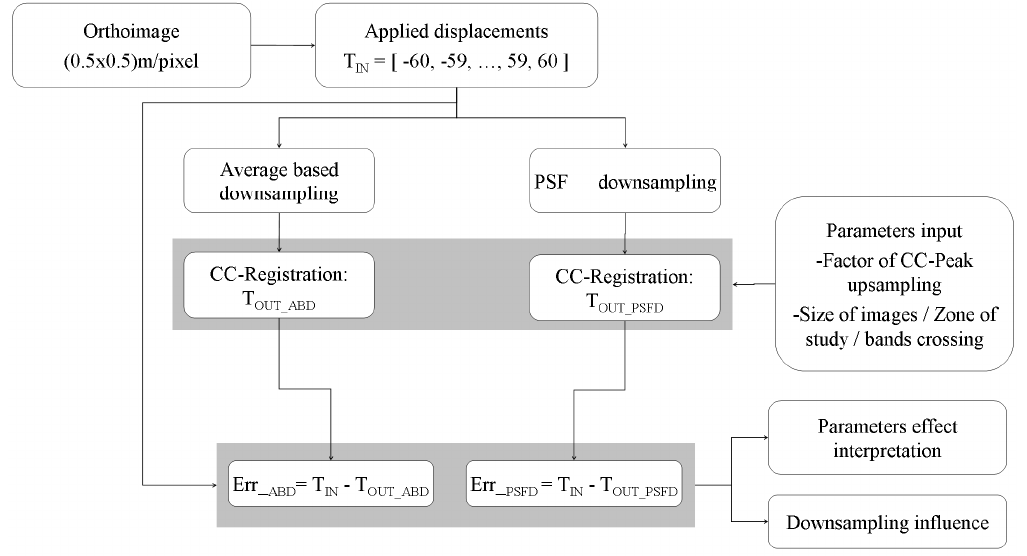
Figure 2. Test workflow. The main factors analyzed were the two testing datasets, the parameters employed and their mutual interaction.